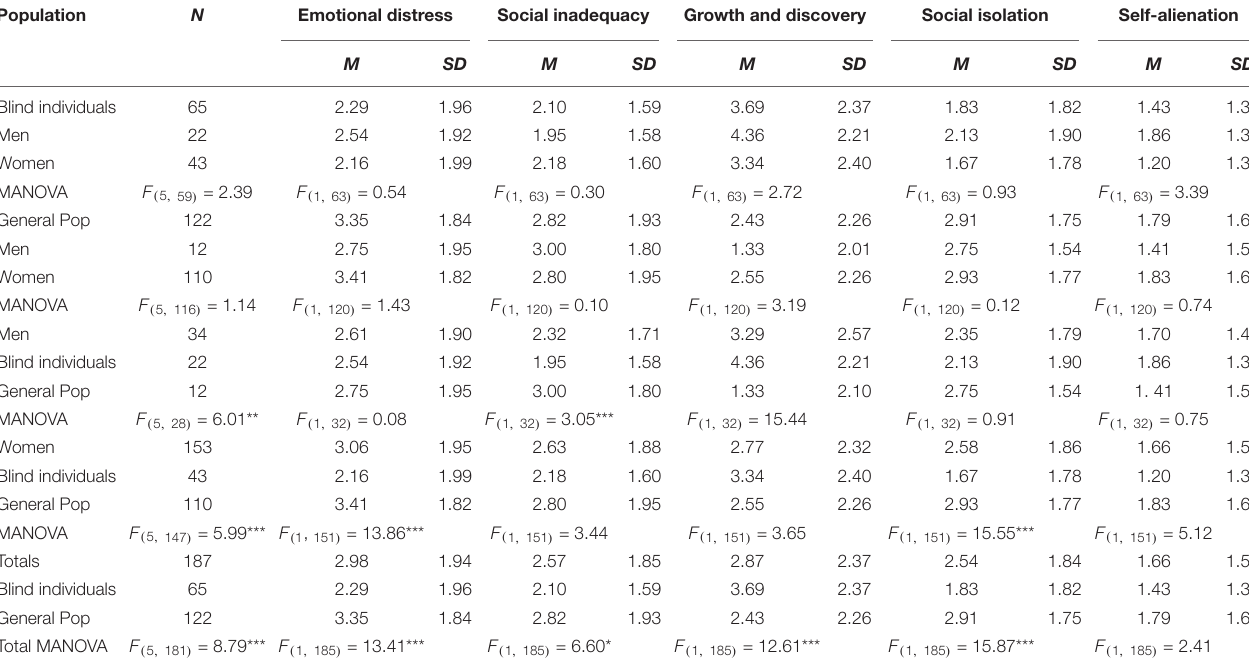
TABLE 2 | Mean subscale scores and f ratios for the populations under study.